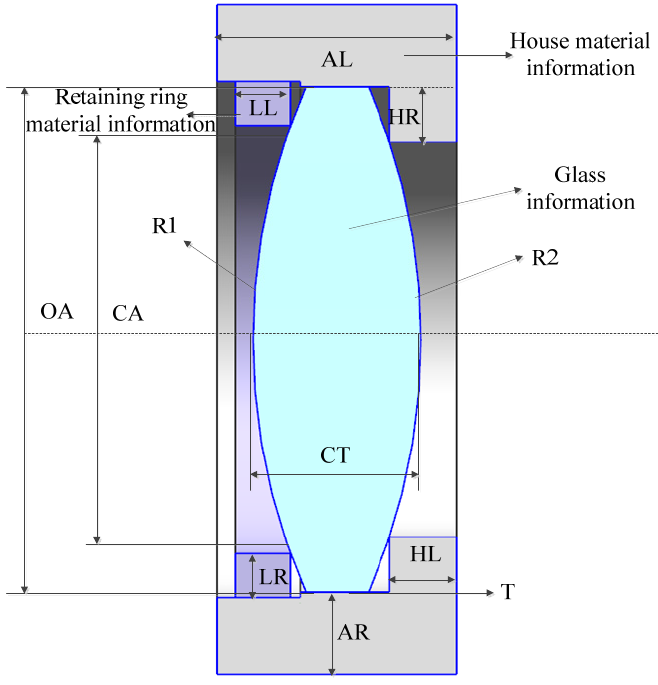
Figure 10. Single-lens FEA unit. Table 5. Parametric data.